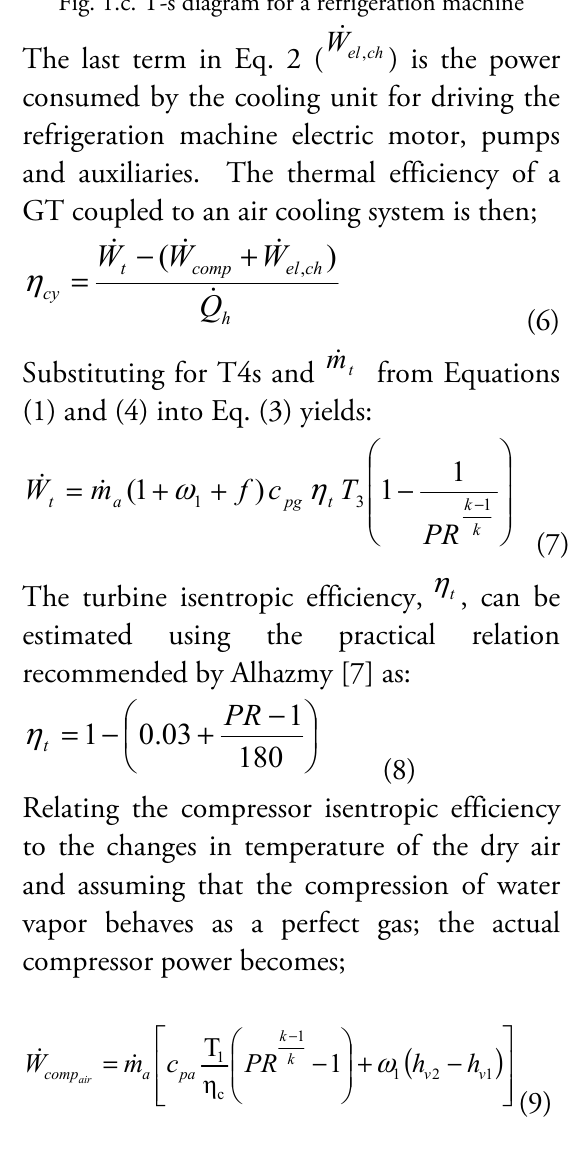
Fig. 1.c. T-s diagram for a refrigeration